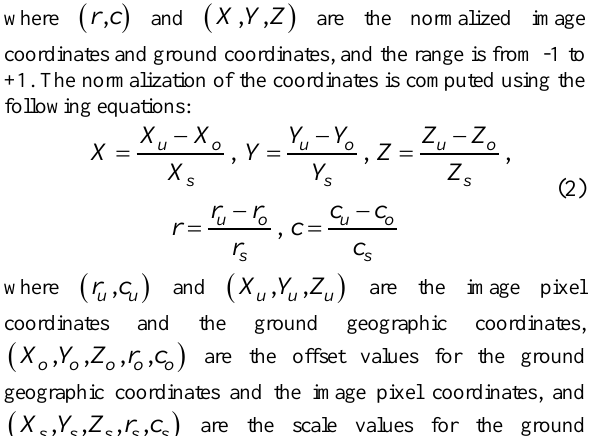
Figure 1. The method used to evaluate the geometric quality of satellite